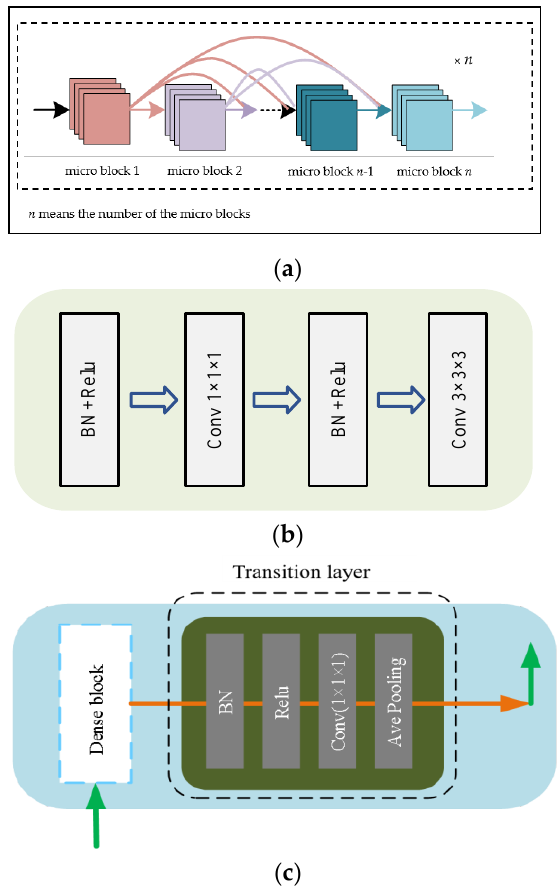
Figure 3. The structure of the dense block [11], micro block, and transition layer: ( a ) the dense block network structure diagram; ( b ) the micro block network structure diagram; ( c ) the transition layer structure diagram.